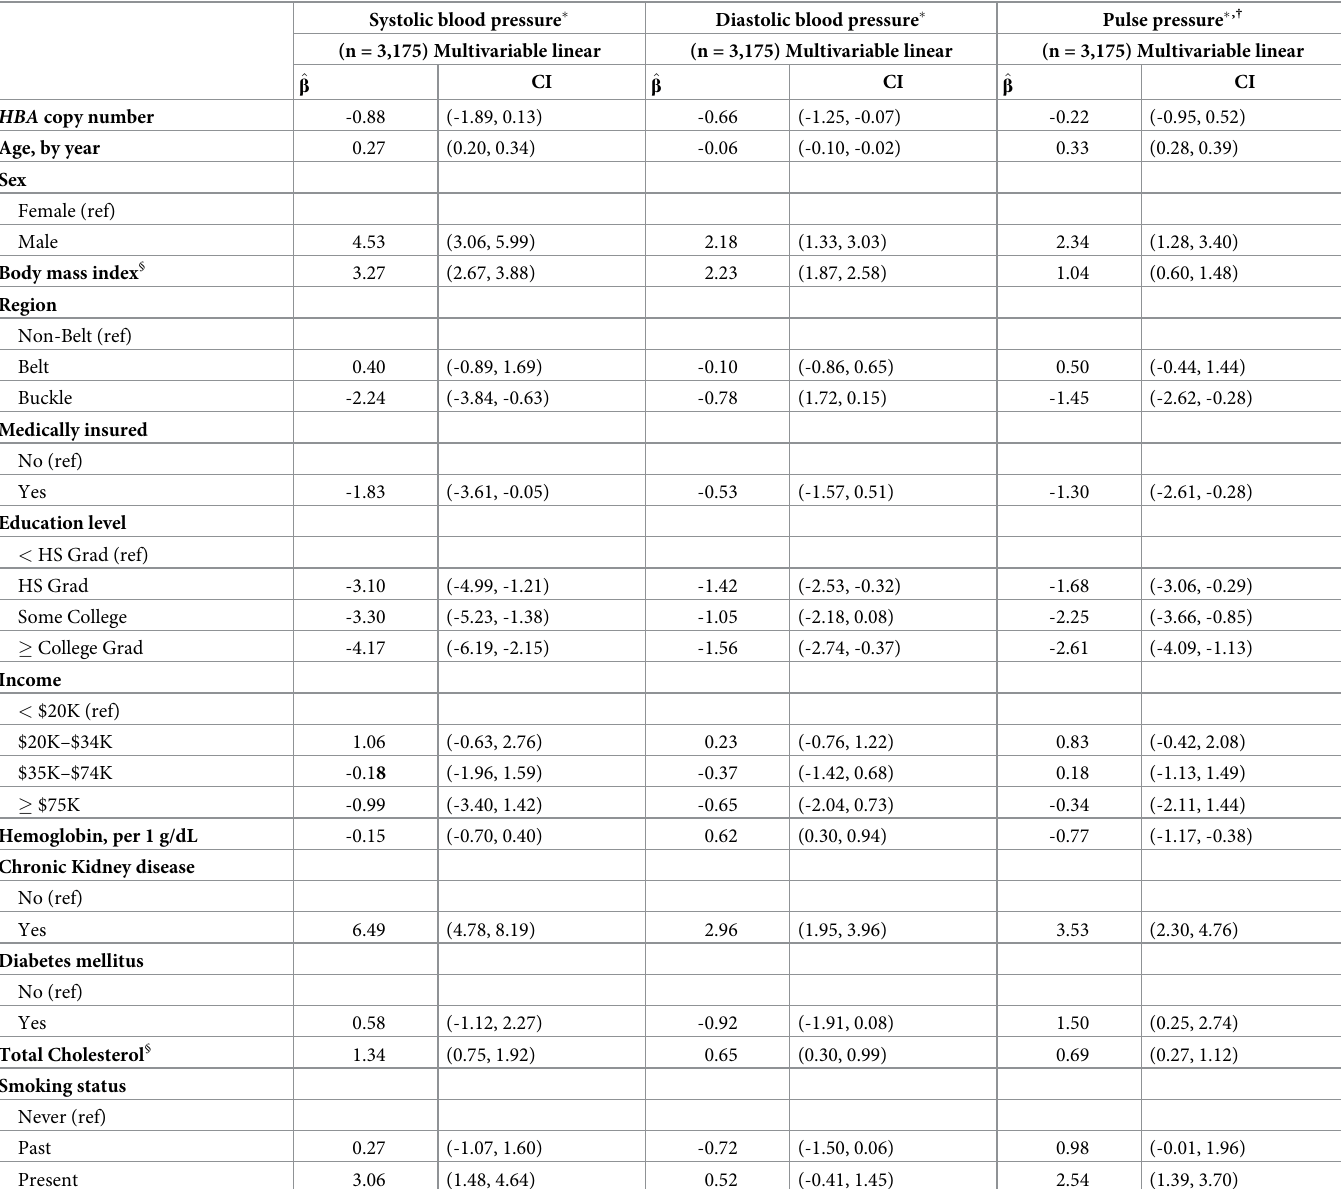
Table 4. Association of HBA copy number with measured blood pressure in subjects not taking anti-hypertensive medications–fully adjusted